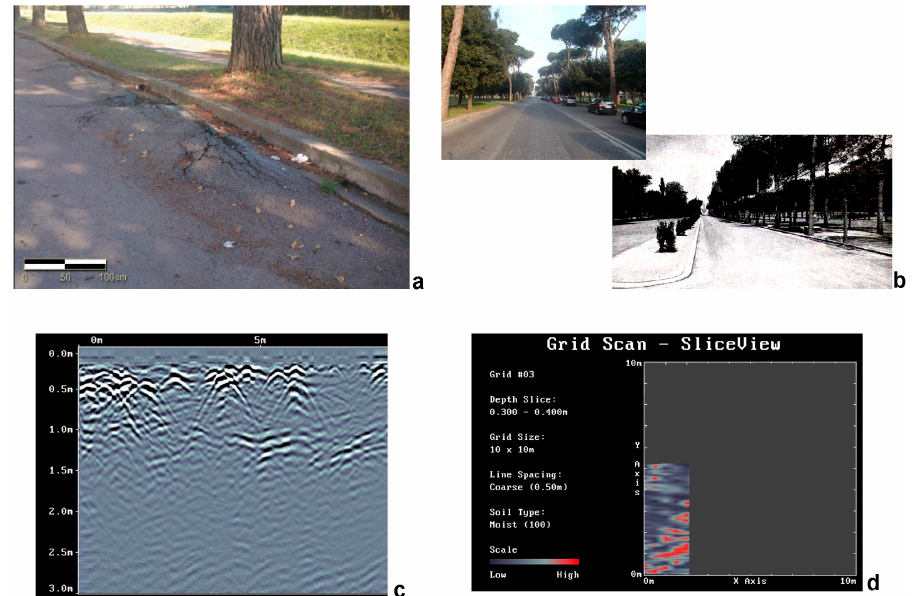
Figure 5. In ( a ), damaged asphalt along Viale delle Terme di Caracalla is shown. This tree-lined street was constructed in 1940s, as shown in ( b ). Strong hyperbolic events and red elongated anomalies in the first 0.4 m, observed on both the radargram ( c ) and depth map ( d ) image the root architecture beneath the asphalt.